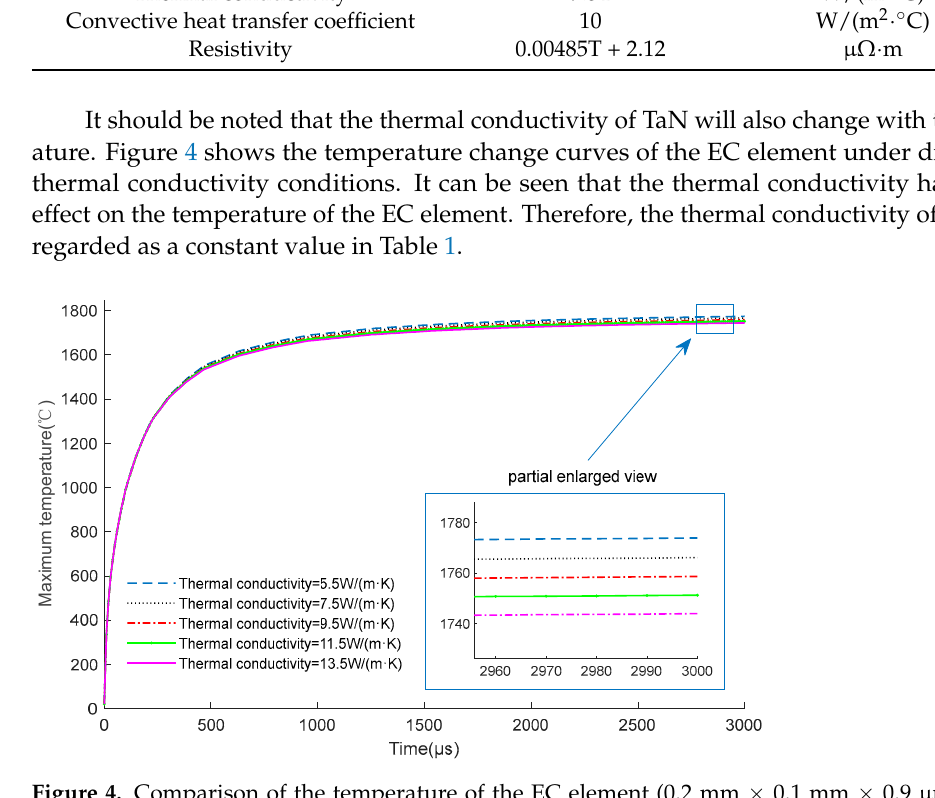
Figure 4. Comparison of the temperature of the EC element (0.2 mm × 0.1 mm × 0.9 µ m) with differ- ent thermal conductivity under 6V constant voltage excitation.